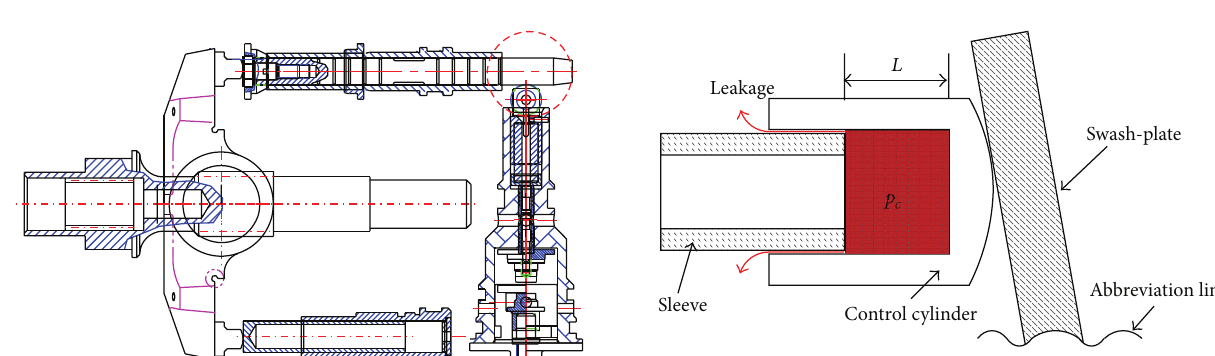
Figure 14: Schematic of the control cylinder